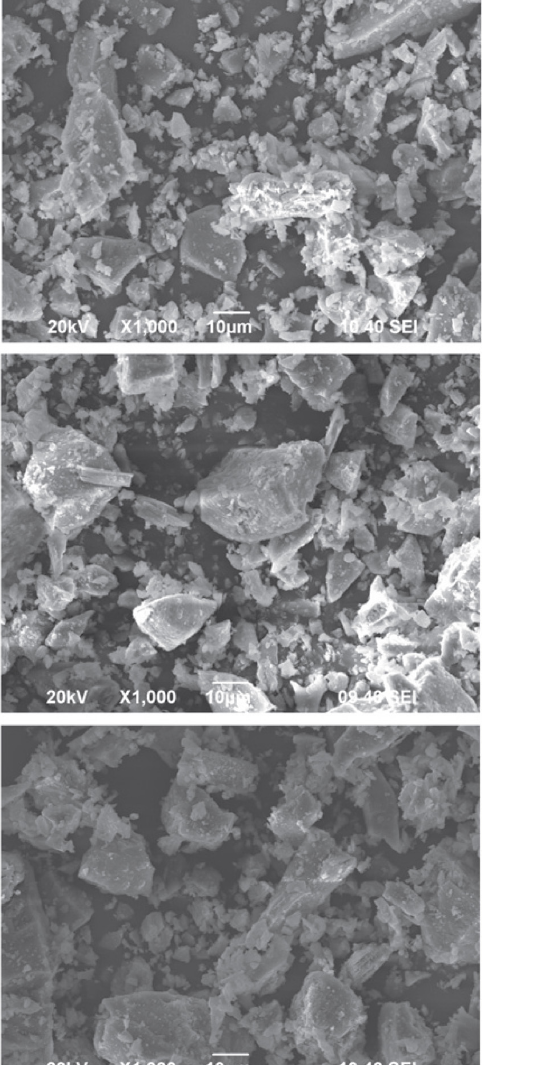
Figure 1. SEM images of VPC particles.